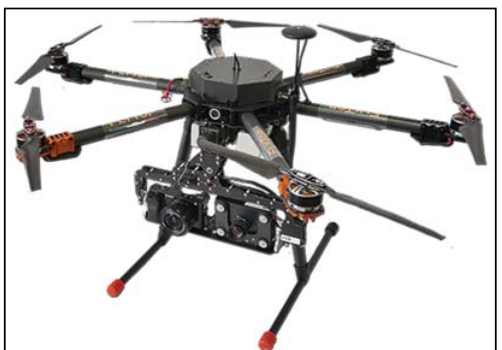
Figure 1: FlyNovex UAV